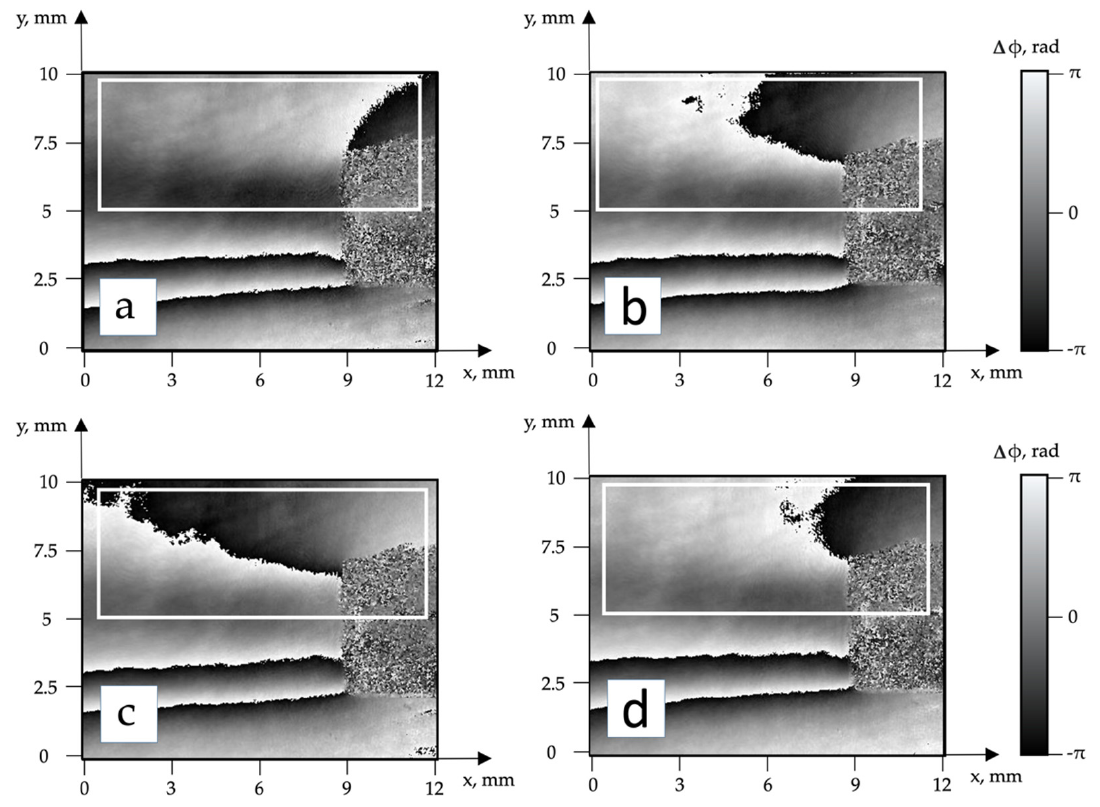
Figure 8. Interference patterns of the refraction observation in the registered sequence of holographic images: ( a )—helium flow; ( b )—start of plasma jet generation; ( c )—plasma generation; ( d )—end of plasma generation.